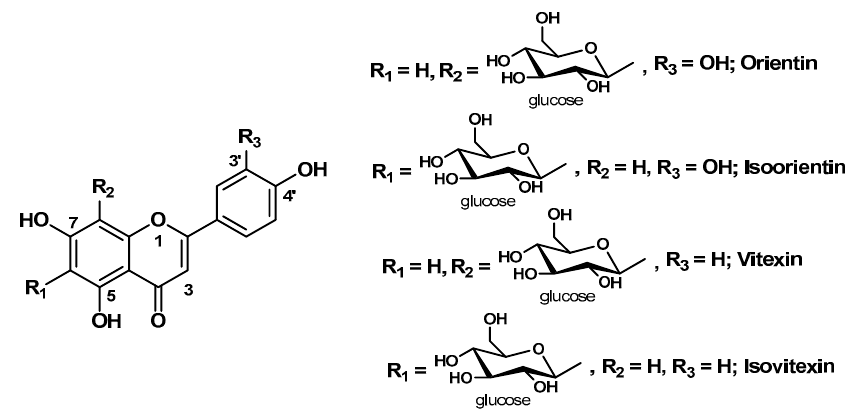
Figure 7. Chemical structure of some flavonoids of Passiflora edulis